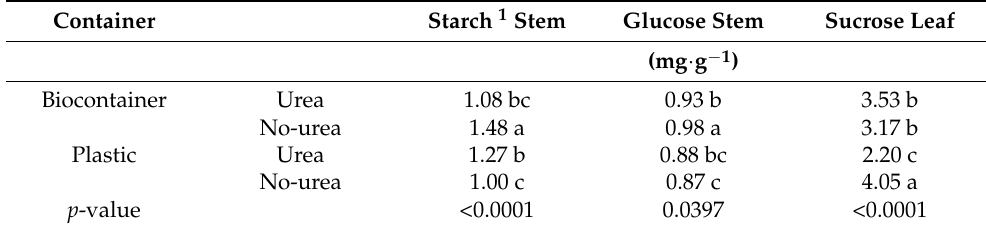
Table 5. Concentrations of carbohydrates in Encore ® azalea ‘Chiffon’ affected by the interaction between container type and foliar urea application.